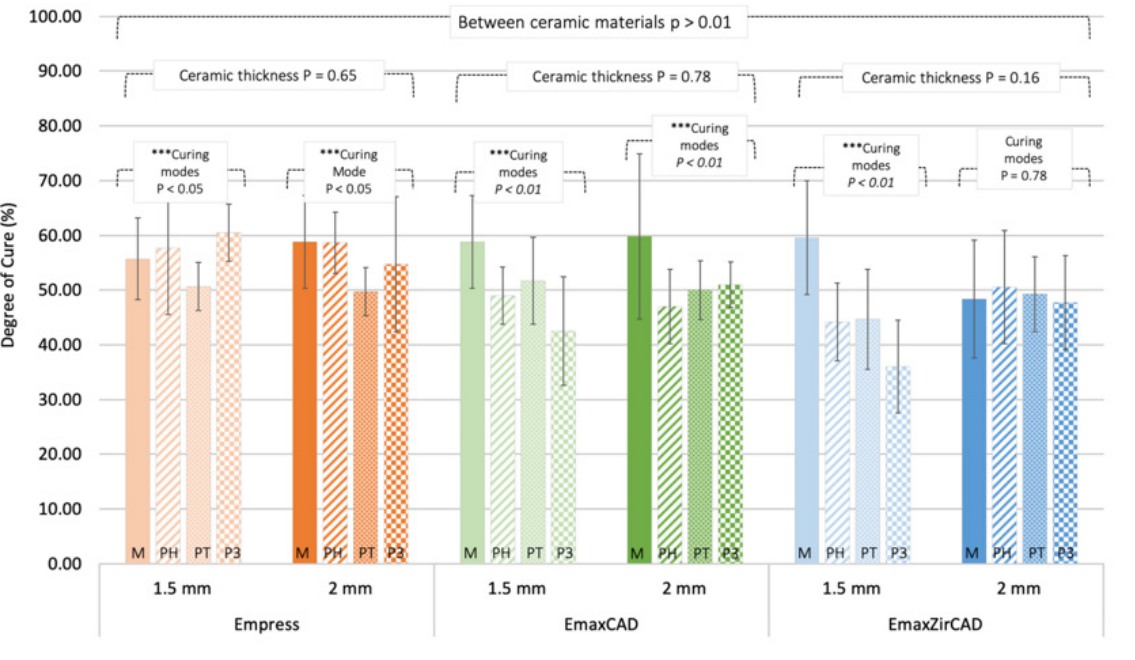
Figure 5. Bar chart plotting the mean and standard deviation of degree of cure (Empress–Leucitre- reinforced; EmaxCAD–Lithium disilicate; EmaxZirCAD–Zirconia) (M–monowave; PH–polywave- high mode; PT–polywave-turbo mode; P3–polywave-3 s mode). *** indicates statistical significance p < 0.01.